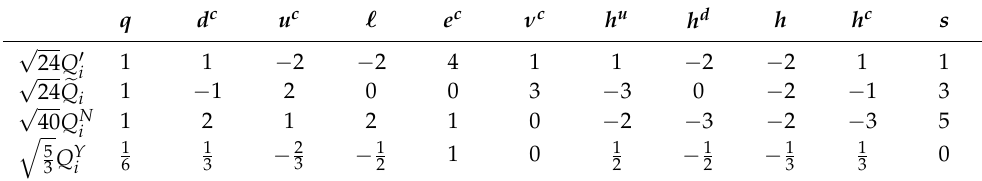
, (cid:101) Q i , Q N and Q Y ) of the components of the 27-plet associated with the U ( 1 ) (cid:48) i i i